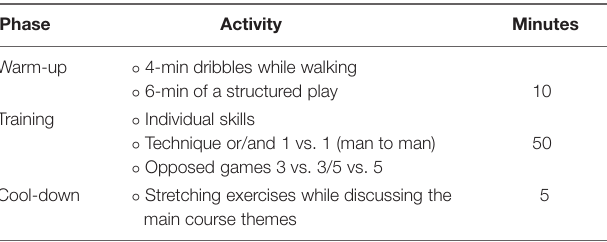
TABLE 2 | Football Exercise